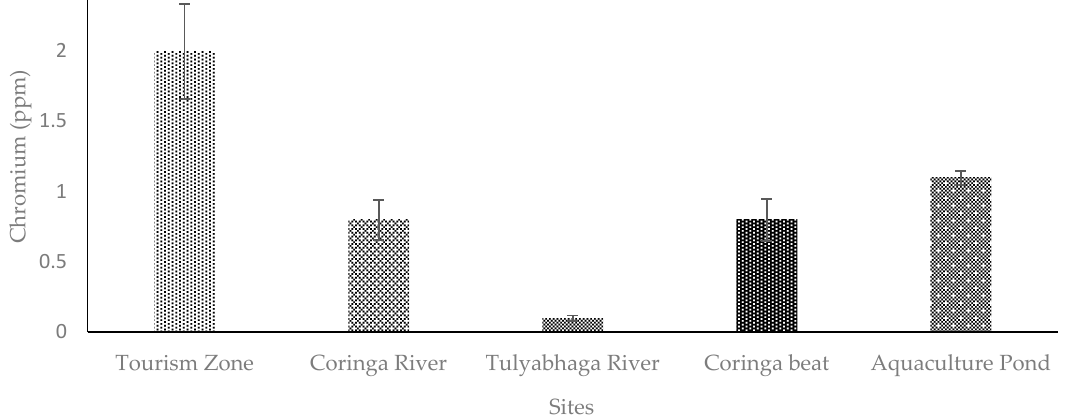
Figure 5. Level of Cr examined in fishing cat scats from different sites of Coringa Wildlife Sanctuary, Andhra Pradesh, India. [Bar indicates mean and line indicates SE; n = 6].